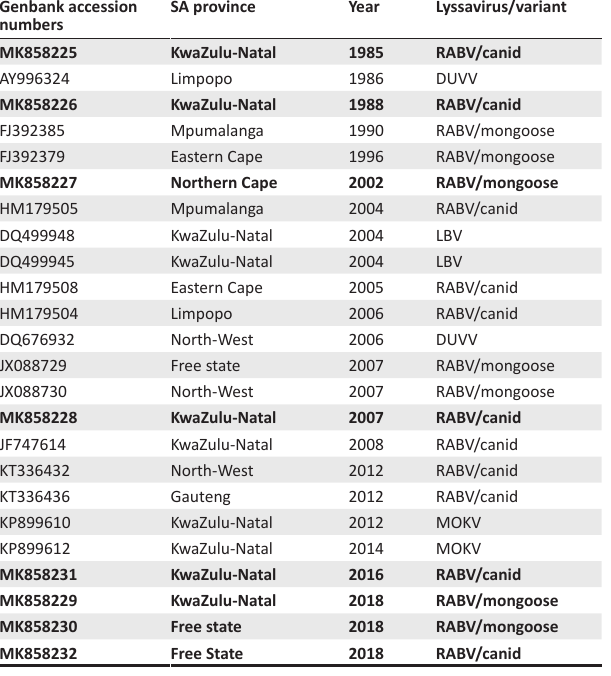
TABLE 1: Viruses included in phylogenetic analysis. Genbank accession numbers